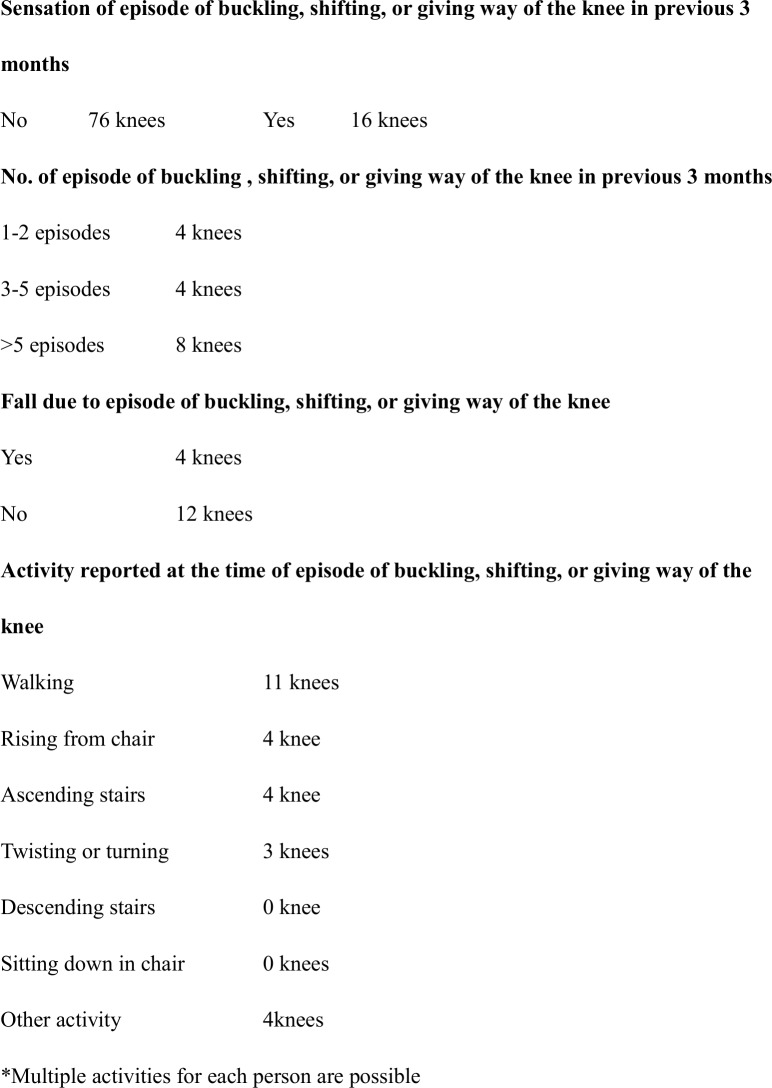
The summary of self-reported knee instability score.